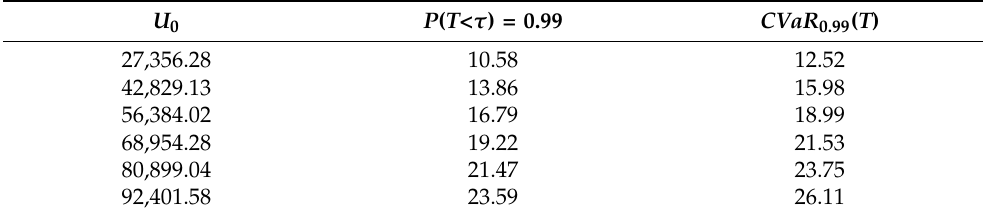
Table 3. Values of VaR 0.99 ( T ) and CVaR 0.99 ( T ) for the random variable of the time to ruin T. U